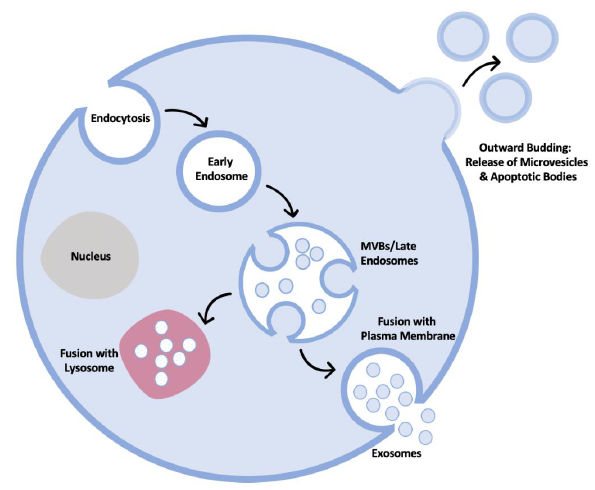
Figure 1. Representation of the several routes known for extracellular vesicle (EV) biogenesis. EVs can be released in the form of microvesicles generated from the outward budding of the plasma membrane, or as exosomes through the fusion of multivesicular bodies (MVB) from within the en- dosomal/lysosomal pathway with the plasma membrane. MVBs can alternatively degrade their cargo by fusing with lysosomes. Similar to that of microvesicles, apoptotic bodies are also released by outward budding in cells that are undergoing apoptosis. The content of tumour-derived EVs is diverse, can vary considerably and is largely dependent on the cell of origin, in a similar manner to normal cell EVs. However, the contents are highly bioactive and are able to elicit a considerable change in the activity of the recipient cells. Some of the molecules carried by cancer-derived EVs include oncopro- teins and oncopeptides, as well as various RNA and DNA species that have the capacity to instigate substantial changes to the tumour microenvironment. These changes often aid the progression of tumour and metastasis development as EVs have been known to fea- ture a role in aspects of invasion and the maintenance of angiogenesis [12–14]. EVs have been described to release factors involved in the epithelial to mesenchymal transition pro- cess via stimulation of the epithelial cells, resulting in increased angiogenesis, extracellu- lar matrix remodelling and the loss of adhesion of tumour cells. This change in the micro- environment encourages the release of tumour cells into circulation whereby they have the ability to travel to alternative locations within the host and form metastases [14]. Ad- ditionally, EVs have the ability to contribute towards the development of an aggressive